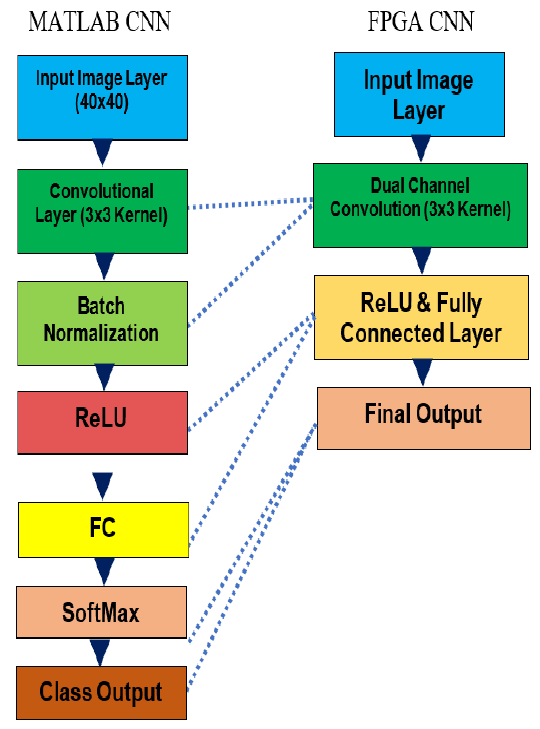
Figure 10. Software architecture of the CNN.